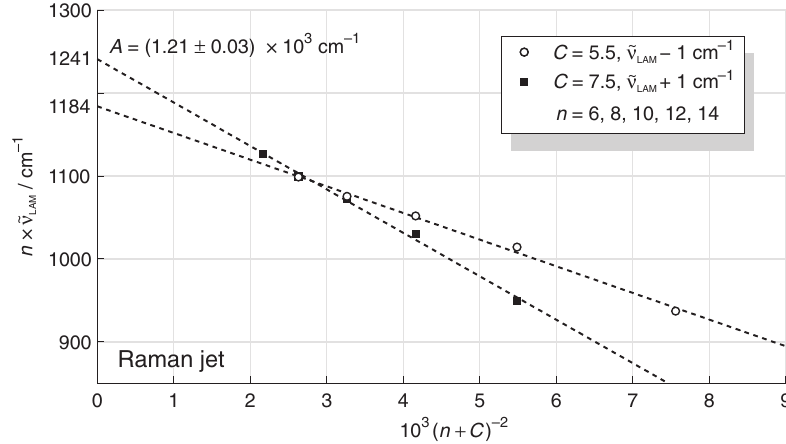
Figure 4. Extrapolation of deperturbed Raman jet LAM-1 wavenumbers to in fi nite chain length ( n